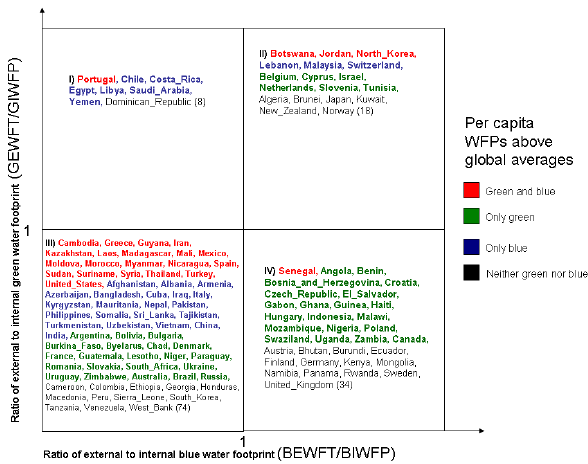
Fig. 5. Classification of countries after their blue and green ratios of Fig. 5 . external to internal WFPs. Countries with values > 1 on the x (y)- axis consume more blue (green) water from other countries than from the own country. For countries coloured in red, BWFP and GWFP per capita exceed the respective global average; blue, only BWFP > global average BWFP; green, only GWFP > global aver- age GWFP; black, BWFP and GWFP < respective global average. Numbers in parentheses at the end of the lists represent the total number of countries in the corresponding